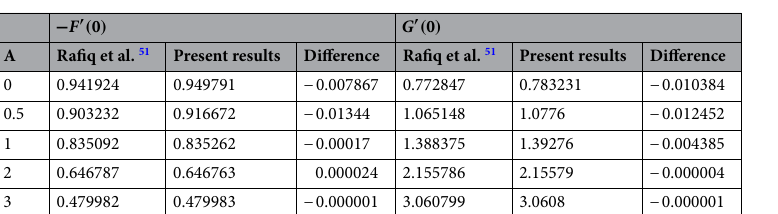
Table 1. Effects of parameter of wall suction A on wall shear stresses F ′ ( 0 ) & G ′ ( 0 ) when Pr = 5, 10000, ε 1. Comparison of current results with those of Rafiq et al. 51 θ e = =